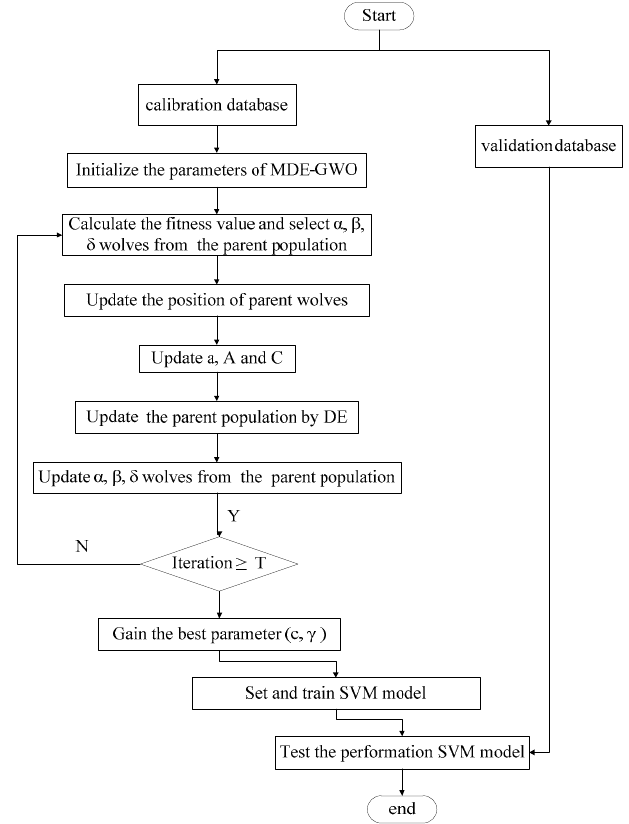
Figure 5. Flow chart of modified differential evolution grey wolf optimization (MDE–GWO–SVM) algorithm.